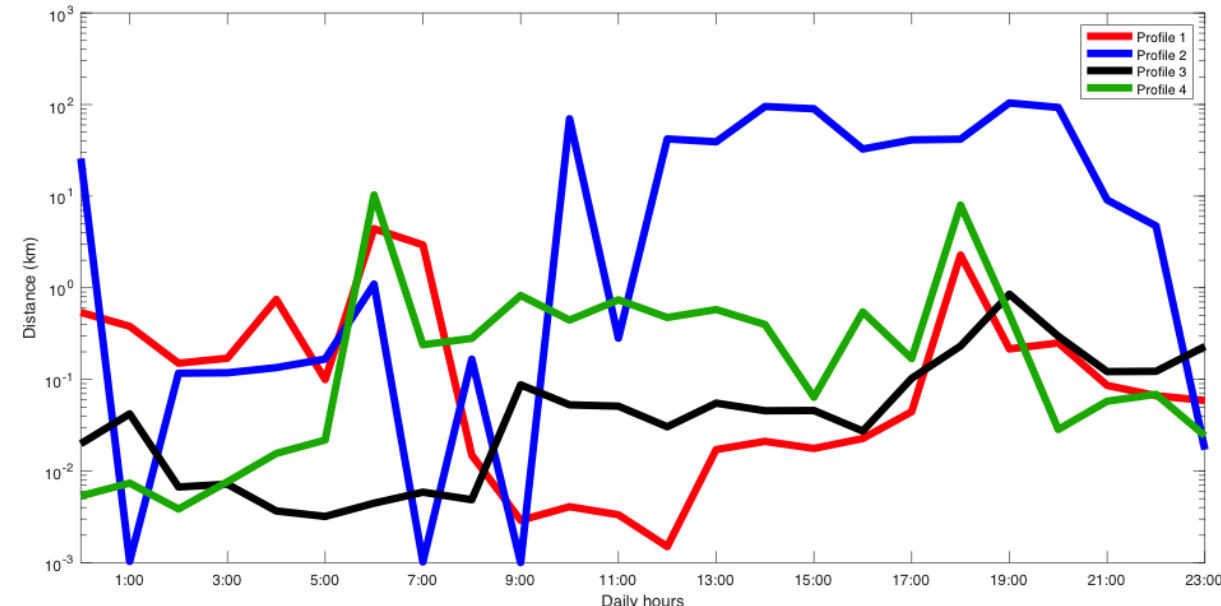
Figure 9. Distance traveled profiles of patient D.